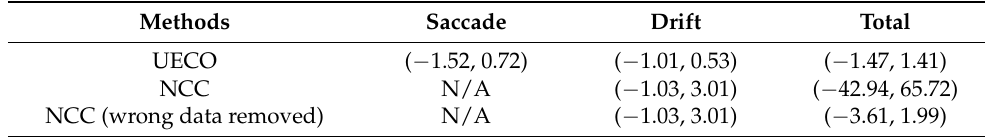
Table 1. The accuracy of vertical displacement.